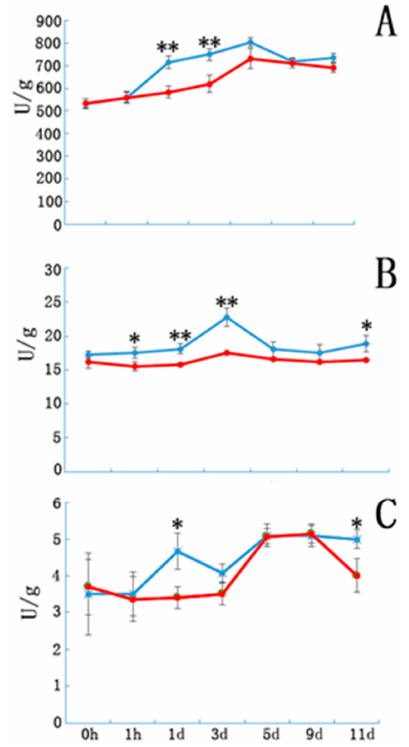
Figure 3. The peroxidase, indole acetic acid oxidase and polyphenol oxidase enzyme activity in etiolated and non-etiolated samples during the different cutting periods. ( A ) Peroxidase, ( B ) indole acetic acid oxidase, and ( C ) polyphenol oxidase enzyme activities (U/g). Etiolated (E) treatment (blue) and control (non-etiolated, NE) treatment (red). * and ** denote significant differences (0.01 < p < 0.05, α = 0.05) or extremely significant differences ( p < 0.01, α = 0.05) between treatments. Error bars represent the standard deviation.